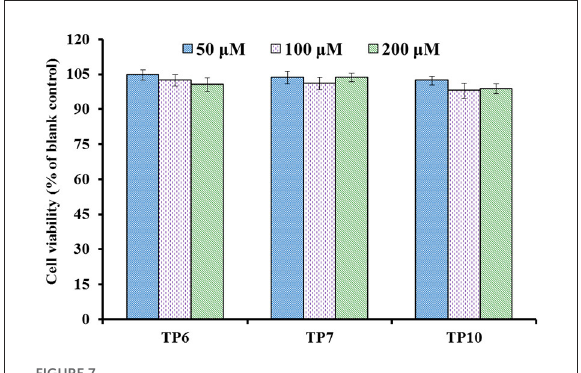
FIGURE7 Cell viability of HUVECs treated with TP6, TP7, and TP10 for 24h,